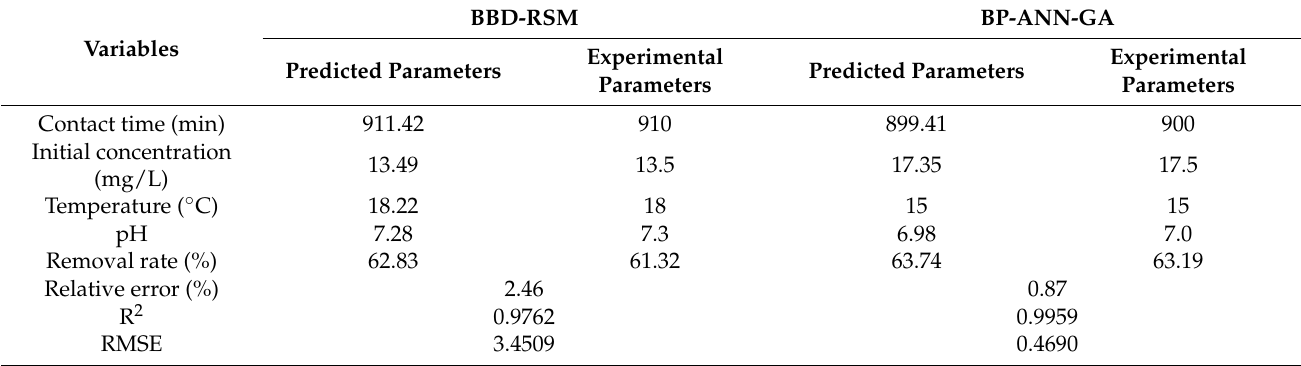
Table 12. Comparison of experimental validation results and predicted results of BBD-RSM and BP-ANN-GA. BBD-RSM BP-ANN-GA Variables Experimental Experimental Predicted Parameters Predicted Parameters Parameters Parameters Contact time (min) 911.42 910 899.41